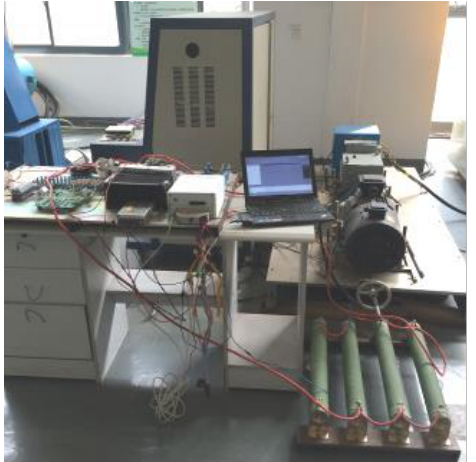
Figure 20. The rapid control prototype test physical map of PMSC.